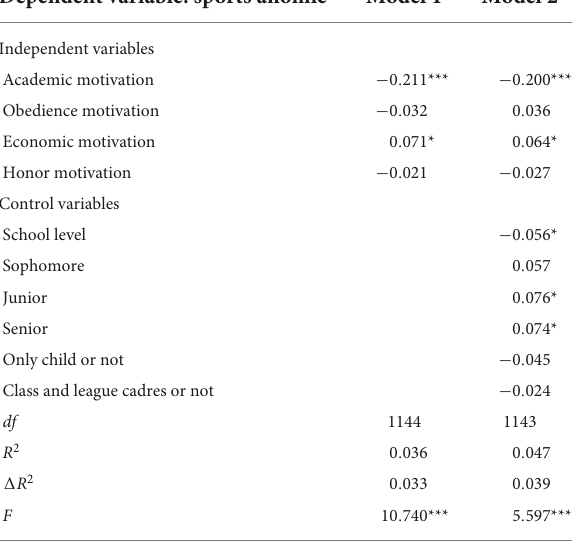
TABLE 3 Multiple linear regression of sports anomie behavior of male college students.